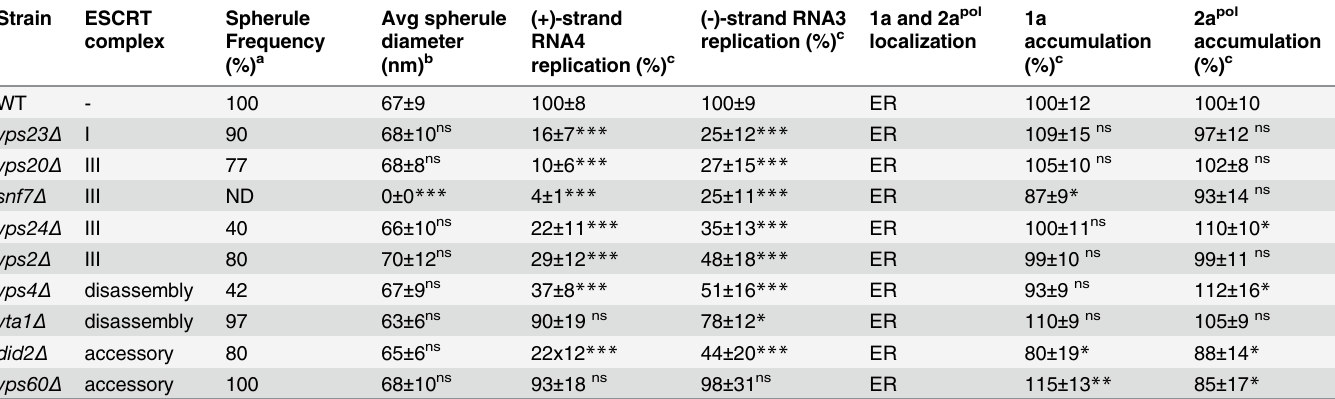
Table 2. Effects of ESCRT deletion on 1a-induced spherule formation and size, RNA4 replication, 1a and 2a pol accumulation and localization. Strain ESCRT complex